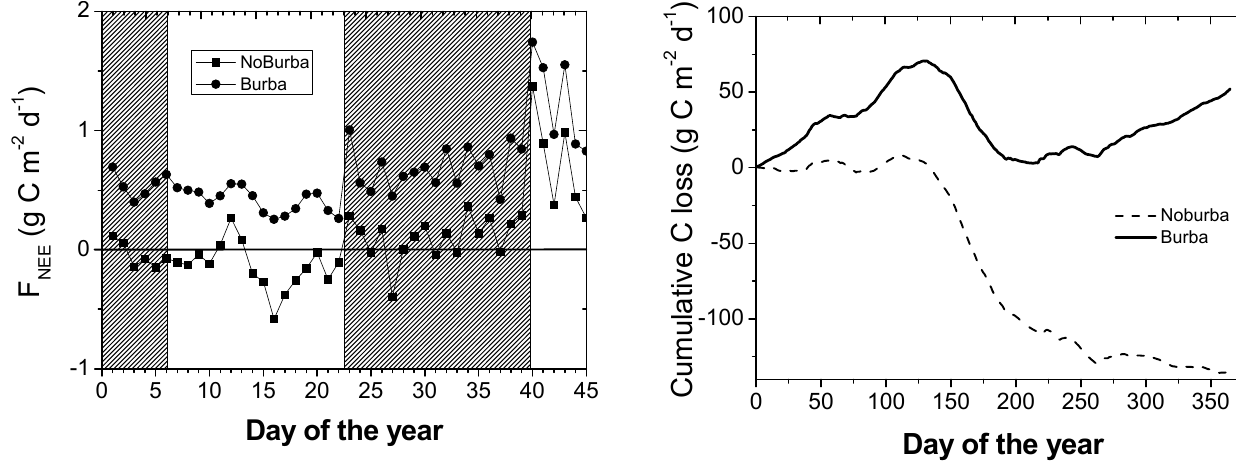
Fig. 7. The NEE flux during the first 45 days of 2007. Black line with squared points is the NEE flux with no correction. Black line with round points is the same NEE but corrected. Shades areas show periods when the ecosystem was snow-covered. Some snowed days have an apparent downward CO2 flux when not correction was applied. The NEE flux corrected from Burba is always above the non-corrected one.